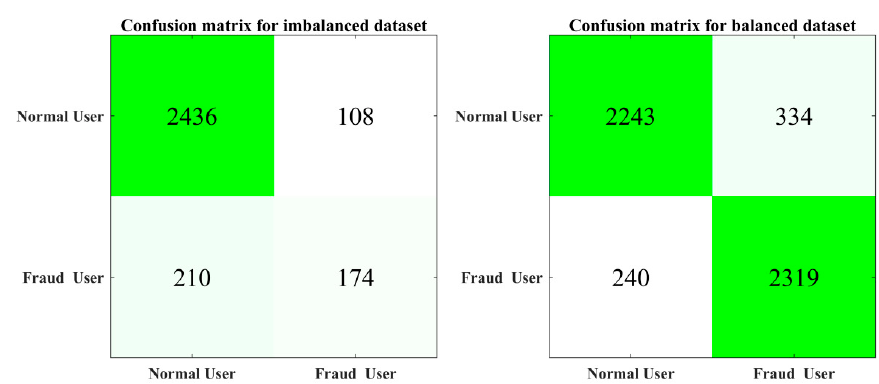
Figure 11. Confusion matrices for the imbalanced and balanced dataset.